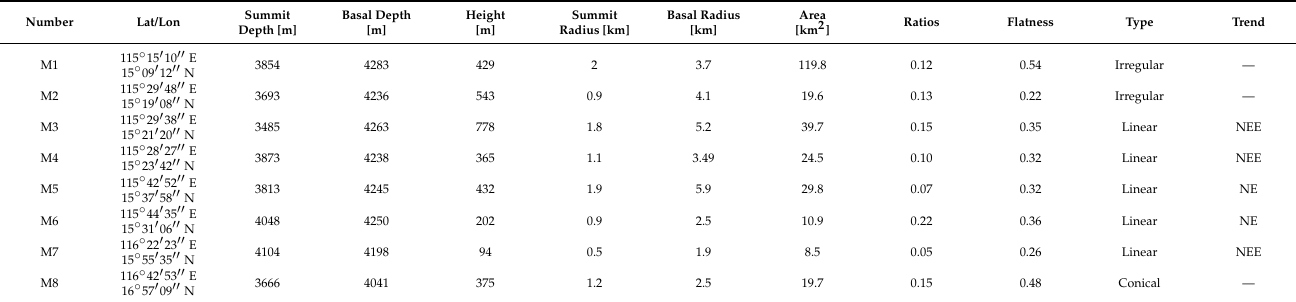
Table 3. Geometry and types of the identified seamounts.